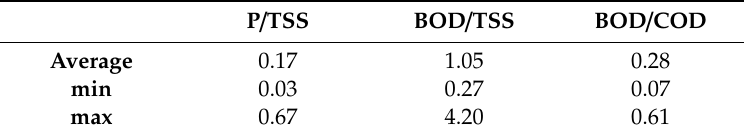
Table 4. Calculated ratios between the chemical oxygen demand (COD), biochemical oxygen demand (BOD), P and total suspended solids (TSS)